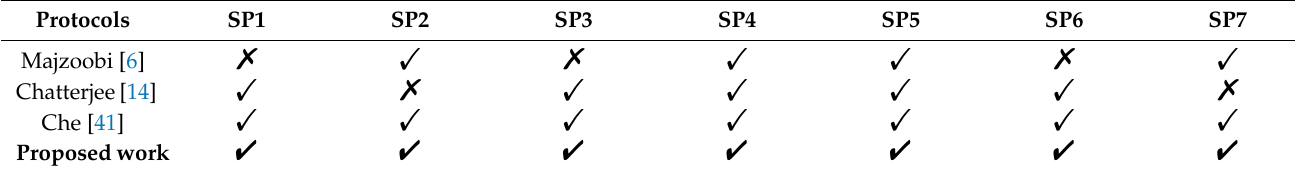
Table 3. Performance comparison based on required